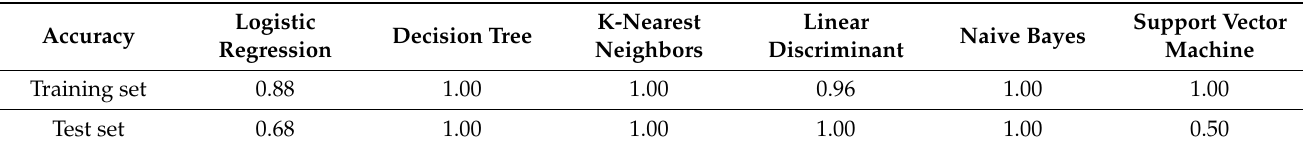
Table 4. Accuracy values for different machine learning algorithms with the combined linear regression approach applied on orthotropic materials’ results.